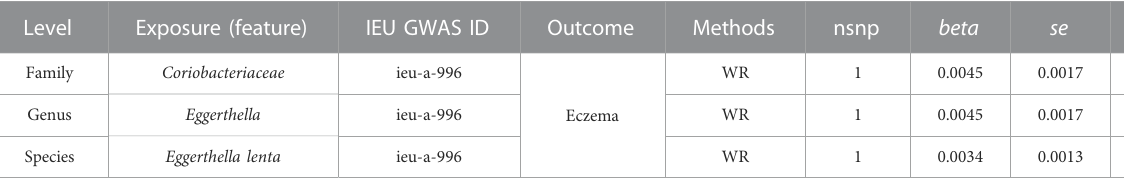
TABLE 1 Signi fi cant 2SMR analysis results between gut microbiome composition and eczema.